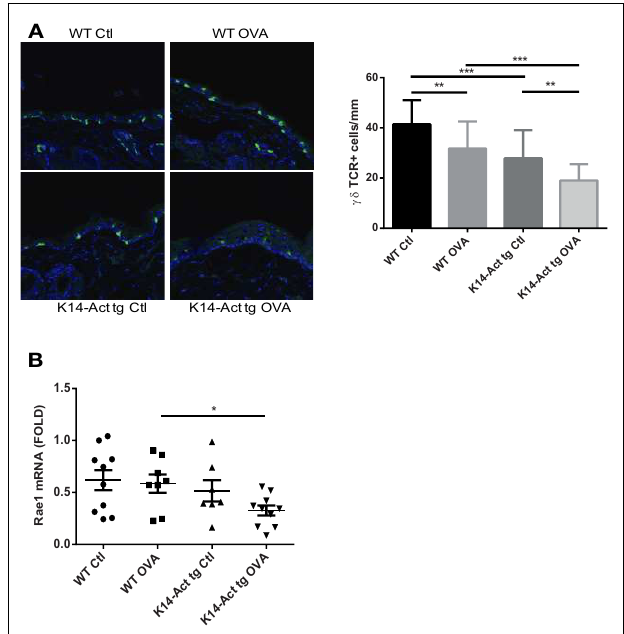
FIGURE 6 |Activin overexpression causes γδ T-cell depletion in the epidermis after mechanical injury and allergic sensitization . (A) Dorsal skin biopsies from the four experimental groups were collected, and cryosections were obtained. Epidermal γδ -T-cells were analyzed with a confocal microscope (20 × objective). Stained cells were quantified and statistical analysis was performed with the Mann–Whitney U -test ( p < 0.01 for ** and p < 0.001 for ***). (B) Real-time PCR was performed using primers specific for mRae-1 . Ct values were normalized to expression levels of the hprt house-keeping gene.The experiment was realized in groups of 8–10 mice for the sensitized mice. Results are presented in a scatter graph and mean values ± SEM are shown. Statistically significant differences were calculated with the Mann–Whitney U -test ( p < 0.05*).